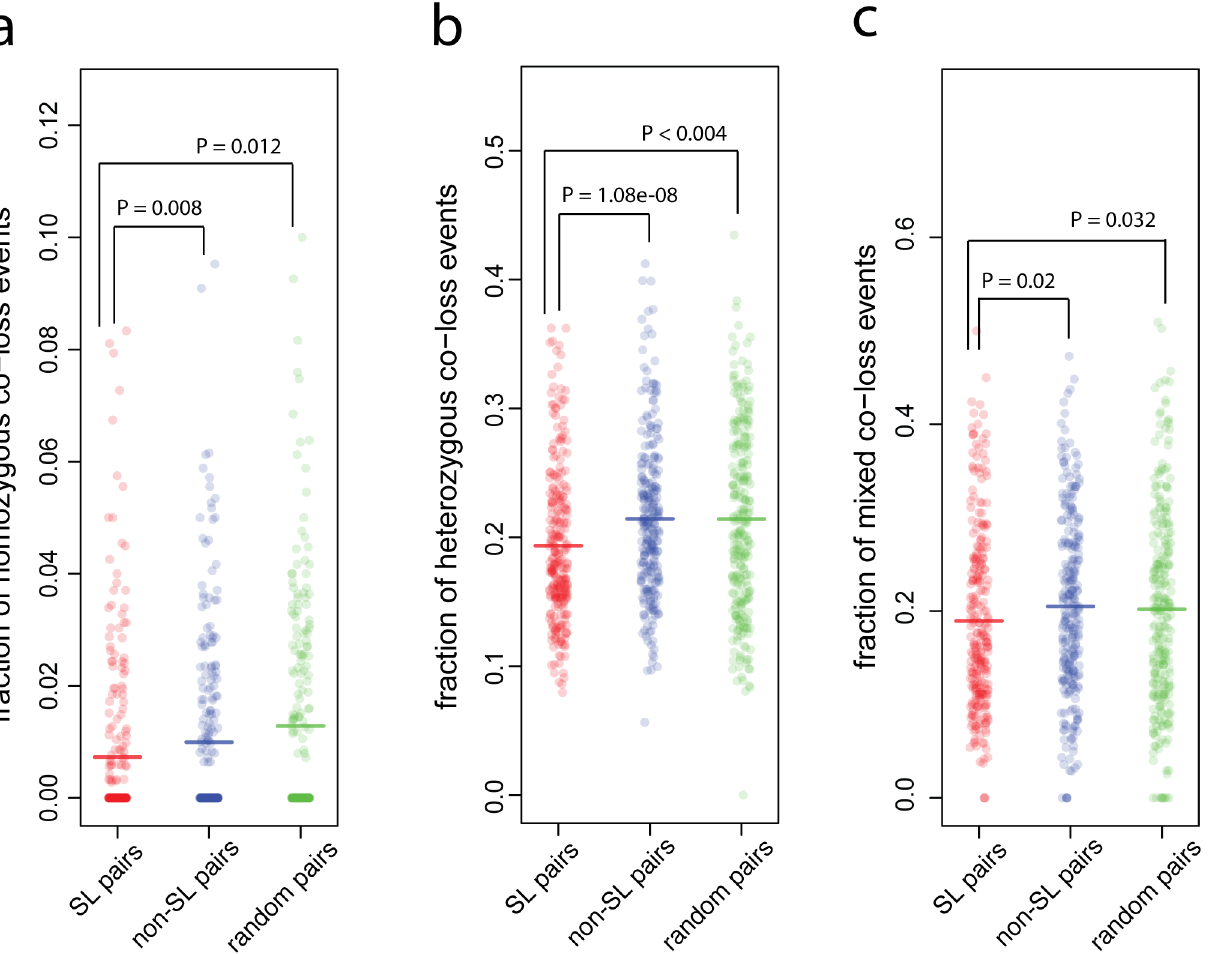
Fig 2. SL pairs are reflected in copy number variations. SL pairs are less likely to have (a) homozygous co-loss events, (b) heterozygous co-loss events and (c) mixed co-loss events than non-SL pairs or random pairs. The fractions for these three types of co-loss events are described as f 1 , f 2 , f 3 in Methods and Fig 1. Each dot is the fraction for a given pair and the horizontal bar represents the mean of the fractions. P-values for the comparison between SL and non-SL pairs were calculated using one-sided Wilcoxon rank test. P-values for the comparison between SL and random pairs were calculated from 1000 randomizations. P-values were adjusted for multiple comparisons using the Bonferroni correction (see details in